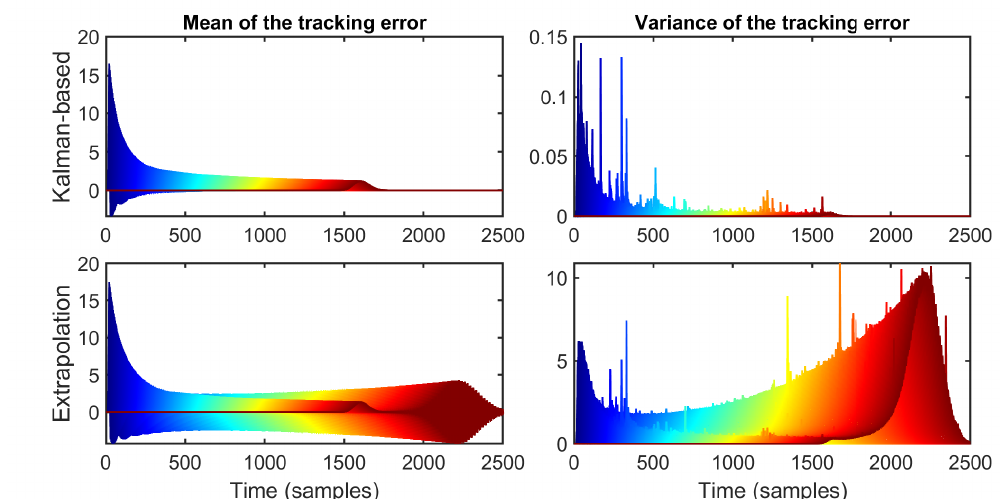
( k ) and variance σ 2 ( k ) of the tracking error for h = 4, p = 0.75, and M = 400 ve- Figure 17. Mean µ ζ ζ i i hicles. In this case, both the mean and variance remain string stable using the Kalman-based strategy, whereas with the extrapolation strategy, the mean and variance exhibit clear string-unstable behavior.